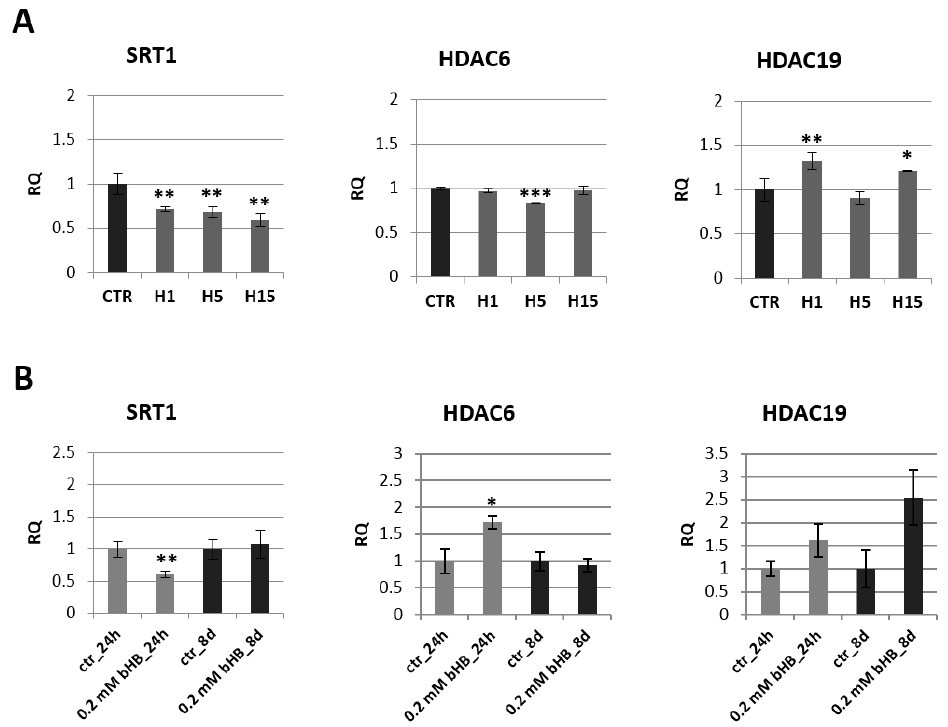
Figure 4. Expression of histone deacetylases in transgenic flax plants ( A ) and in flax treated with 3- HB ( B ). The mRNA level of sirtuin 1 (SRT1) and other histone deacetylases (HDAC6, HDAC19)